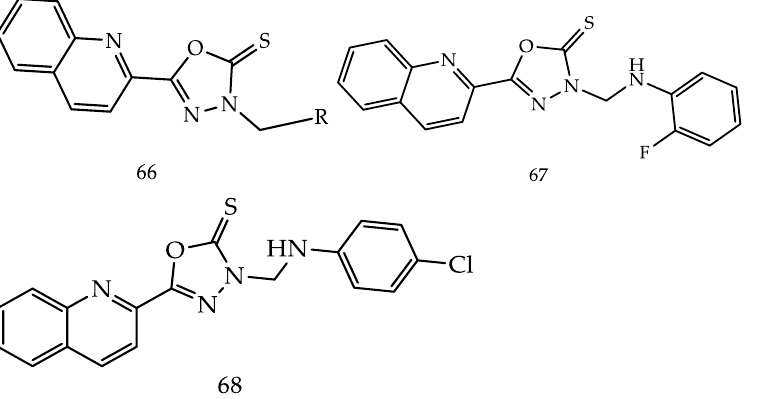
Figure 14. The 2-aminomethyl-5-(quinolin-2-yl)-1,3,4-oxadiazole-2(3H)-thione quinolone derivatives. Zheng et al. synthesized novel 2-chloropyridine derivatives possessing